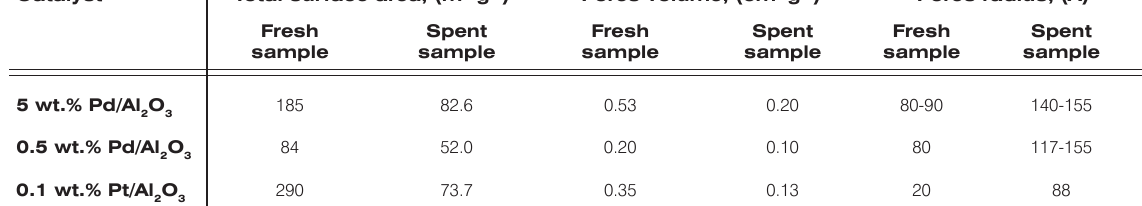
Table 1. Surface characteristics of catalysts before and after reaction. Catalyst